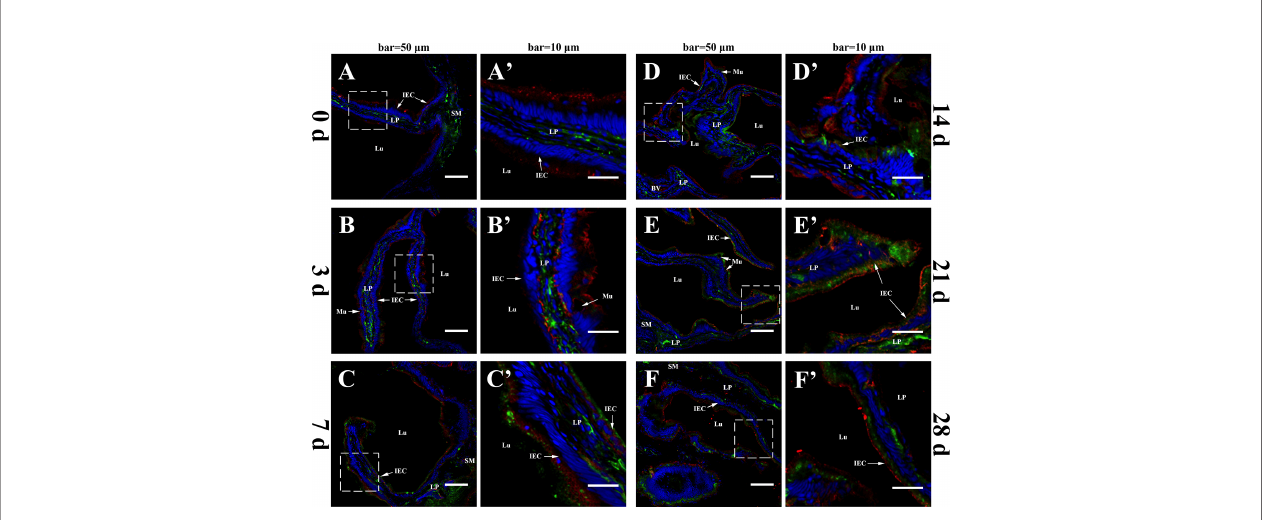
FIGURE 1 | In-vivo evidence of transepithelial transport of the fpIgR – IgM complex in fl ounder. The IgM and the fpIgR in the hindgut were double-stained at different times after the fl ounder was immunized with inactivated Vibrio anguillarum . (A – F) Observation of co-localization of IgM and the fpIgR was at 0, 3, 7, 14, 21, and 28 days post-immunization (dpi), respectively. IgM-positive green fl uorescence was located in the lamina propria at 0 dpi and then presented and increased in intestinal epithelial cells from 3 to 28 dpi, whereas fpIgR-positive red fl uorescence was mainly in epithelial cells. Bar = 50 µm. (A ′ – F ′ ) A higher magni fi cation view of the insert area (white box) in (A – F) , respectively. Bar = 10 µm. Cell nuclei were counterstained in blue with DAPI. LP, lamina propria; Lu, lumen; IECs, intestinal epithelial cells; Mu, mucus cells; BV, blood vessel; SM,